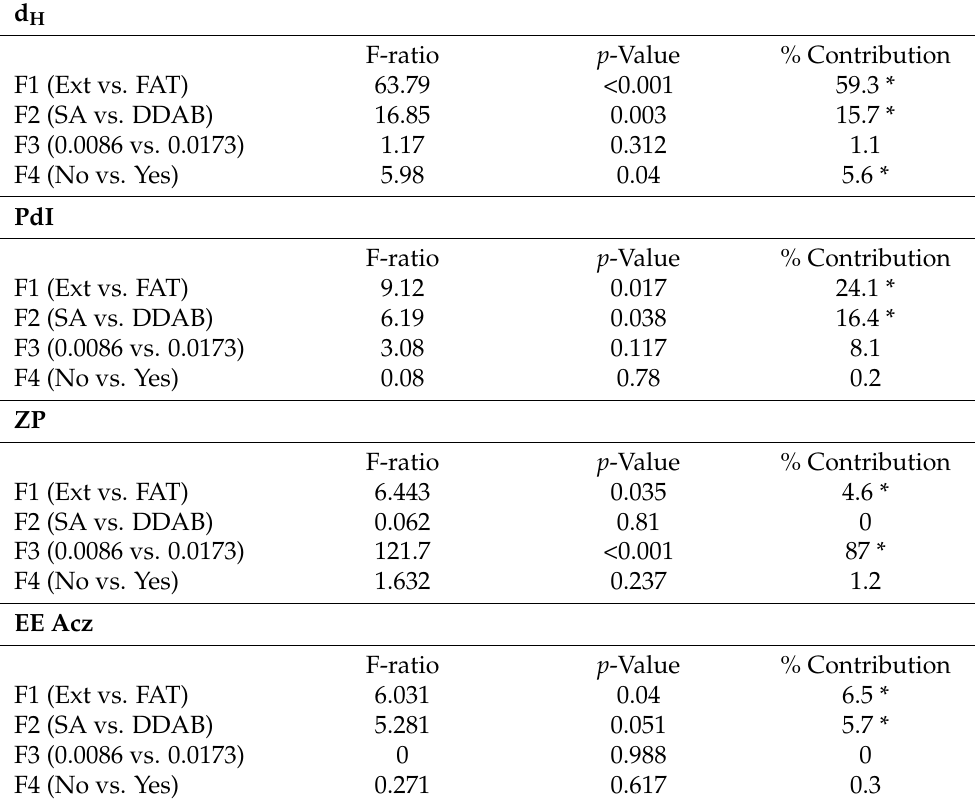
Table 4. ANOVA analysis for the responses evaluated. A p -value < 0.001 was considered statistically significant (*). F1: method for reducing size; F2: cationic lipid; F3: amount of cationic lipid (mmol); F4: double